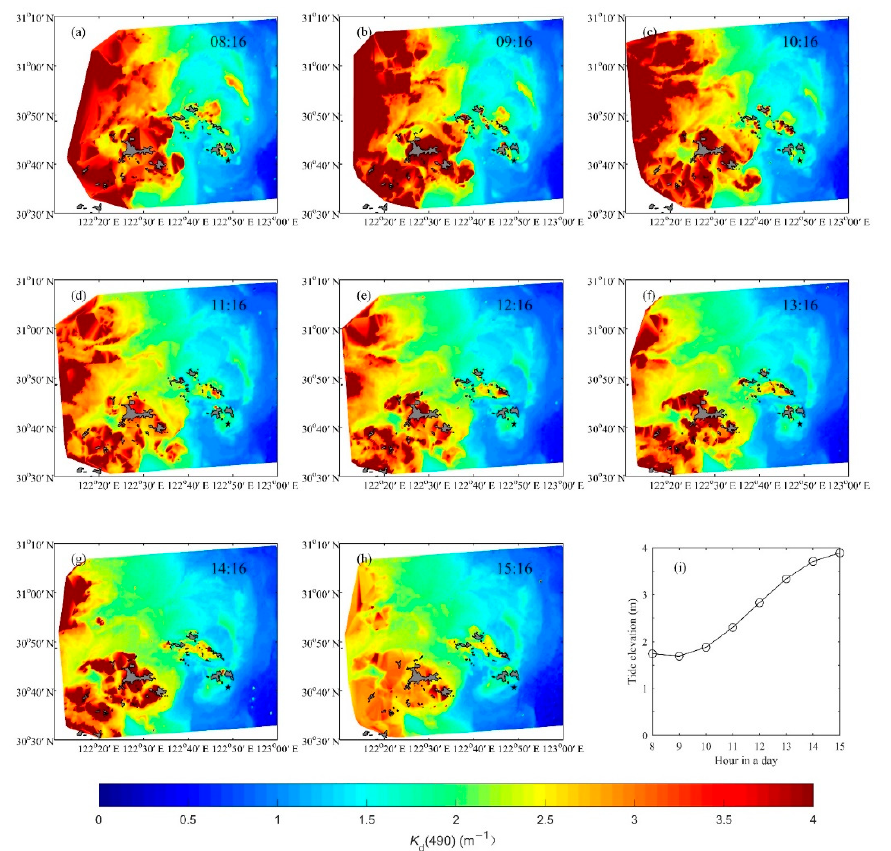
Figure 13. Hourly maps of K d ( 490 ) in the target high-frequency red tide area retrieved from the GOCI images on 12 October 2013. The labeled time in the image corresponds to the observation time in BJT. The black pentacle refers to the site of the moored optical buoy. The last sub-plot shows the synchronous hourly tide elevation observed from Lv Huashan tide gauge